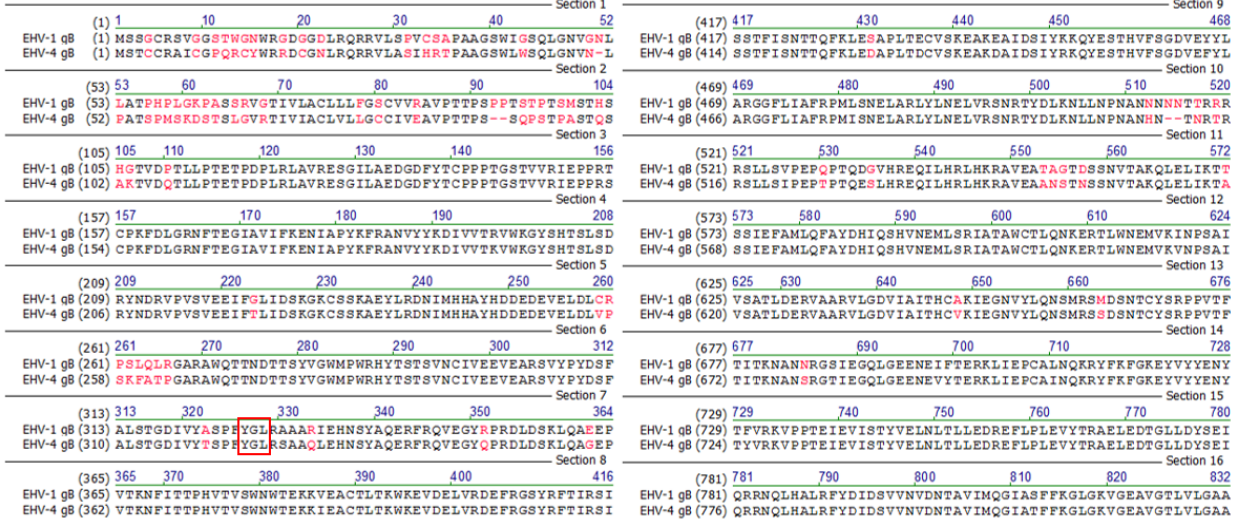
Figure 1. Amino acid sequence alignment of Equine Herpesvirus Type 1 and Type 4 (EHV-1 and EHV-4) glycoprotein B (gB). The putative integrin-binding motif tyrosine-glycine-leucine (YGL) present in the extracellular domains of both gB1 and